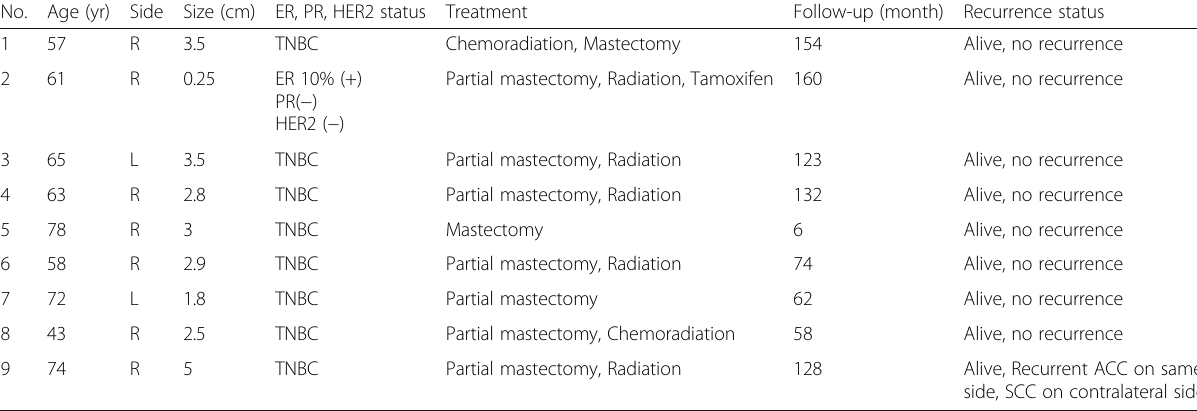
Table 1 Clinicopathological features of nine cases of breast adenoid cystic carcinoma No. Age (yr) Side Size (cm) ER, PR, HER2 status